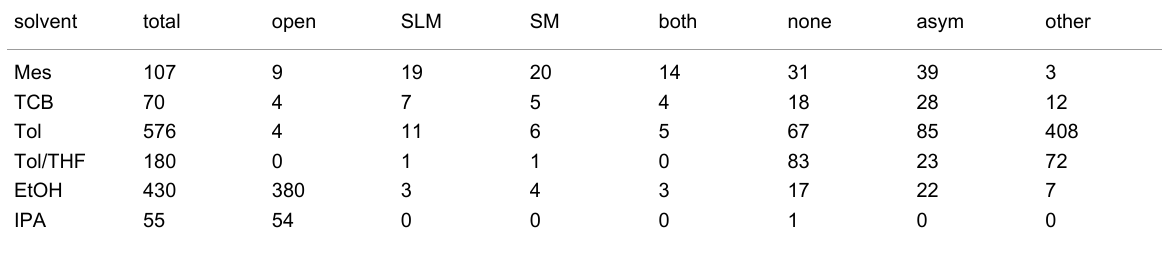
Table 1: Statistics regarding the molecular properties and the fitting of the I – V characteristics with the SLM and the SM. The numbers indicate the total number of I – V s recorded for the individual solvents (total), the number of I – V s showing pronounced hysteresis (open), the number of I – V s that can be fitted with the SLM, the SM, both or none of the models as well as the number of S-shaped but asymmetric I – V s (asym). The number of I – V s with jumps or kinks or other irregularities that, therefore, did not fulfil the stability criteria, are summarized in the last column (other).